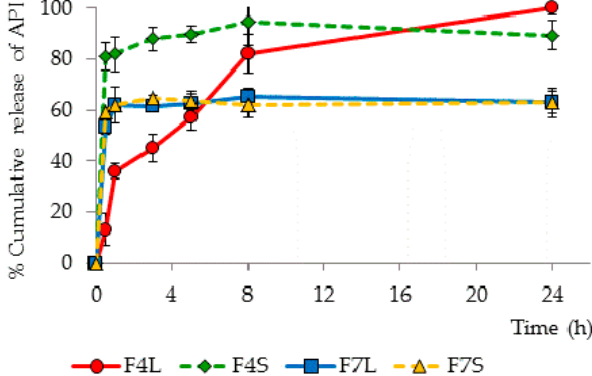
Figure 3. Release profiles of CsA (F7L and F7S) and SPIR (F4L and F4S) from selected SLM formulations before (FL—liquid formulations) and after (FS—spray-dried formulations) spray drying. API: active pharmaceutical ingredient.